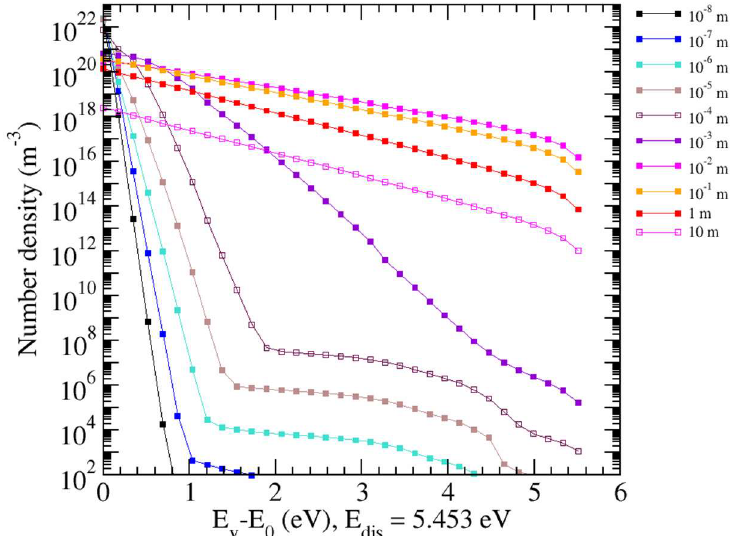
Figure 3. Evolution with the position from the shock front (indicated on the right) of the Boltzmann plot of the CO 2 ( i ,0,0) vibrational states. The vibrational excitation energy relative to the ground state is given in abscissa. The dissociation energy of the CO 2 molecule is reminded.